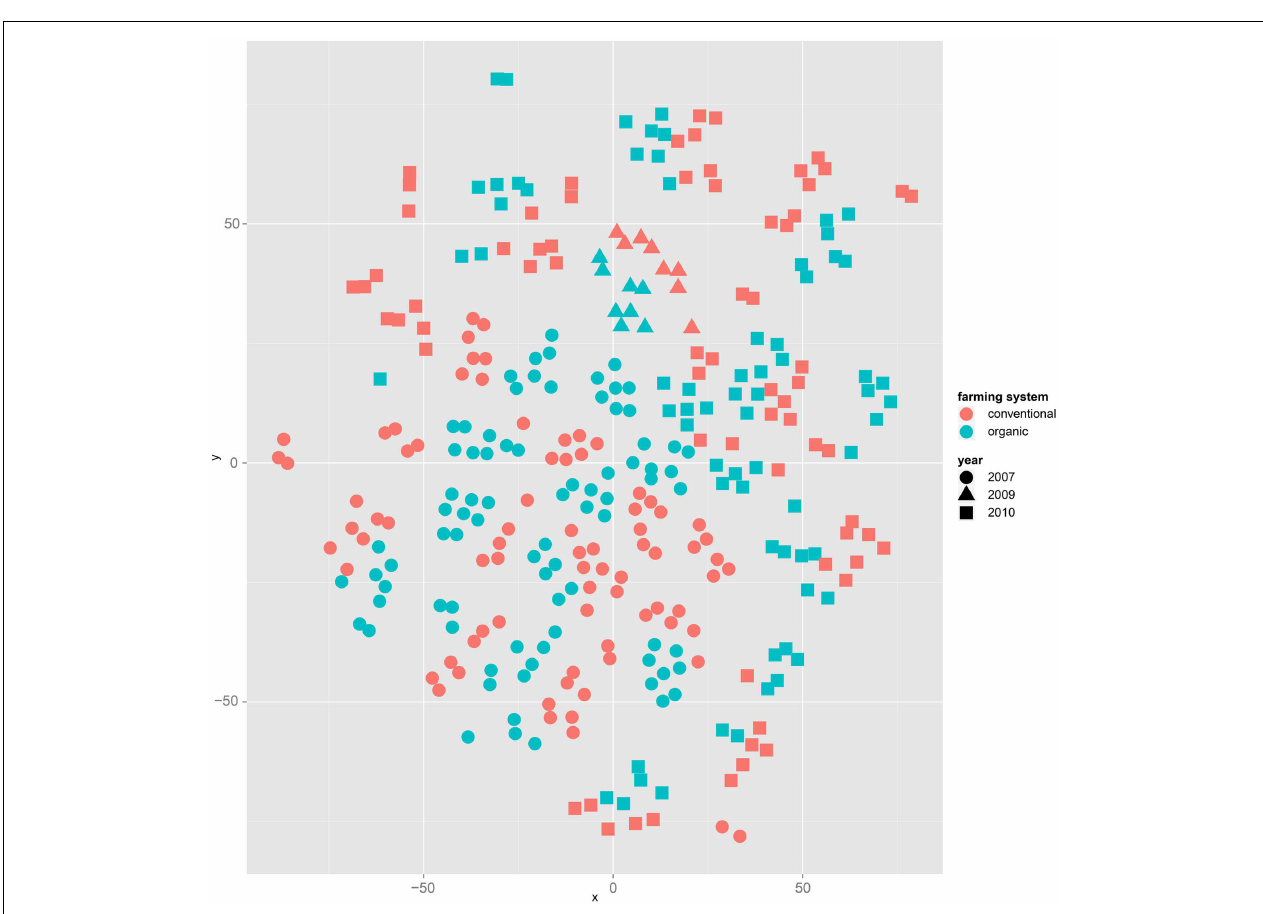
FIGURE 6 |The same t-SNE result as in Figure 5, but colored by farming system: clusters representing cultivars form subclusters according to the factor farming system .